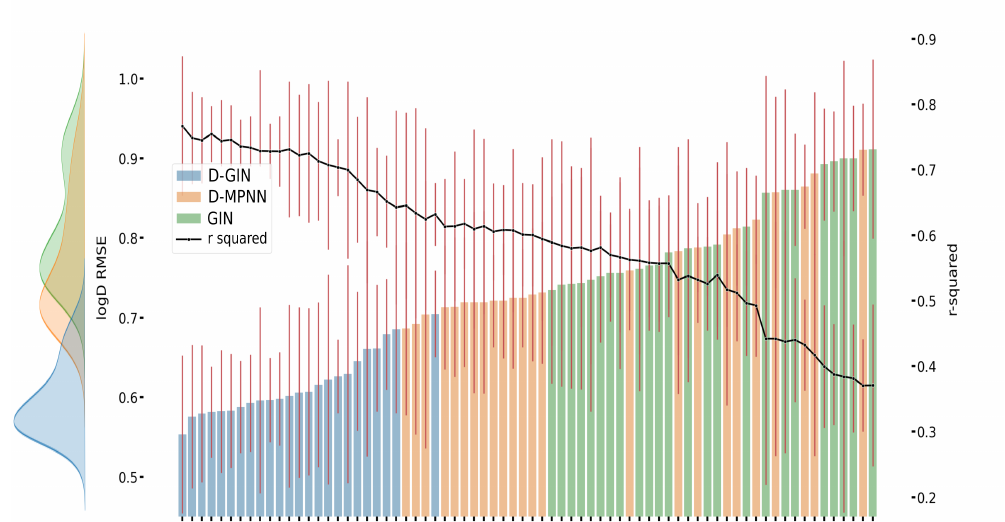
Figure 3. LogD prediction results for each GNN model instance. The left y-axis specifies the logD RMSE and the right, secondary x-axis the corresponding r 2 values for each GNN model. D-GIN is colored blue, D-MPNN orange, and GIN green. Each of the bars represent a different trained model-a detailed description can be found in Figure A1 in the Appendix A. The accumulated kernel density for each model type is shown on the very left side. The red lines correspond to the 95% confidence intervals. The model names are a combination of model type (D-GIN, GIN, D-MPNN), training approach and featurization type-a detailed description of each model name can be found in Tables A8–A19 in the Appendix